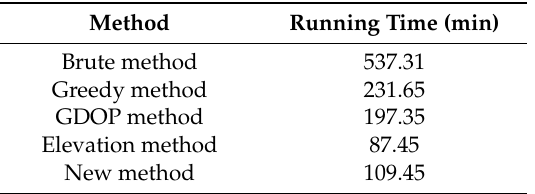
Table 10. Running time of different